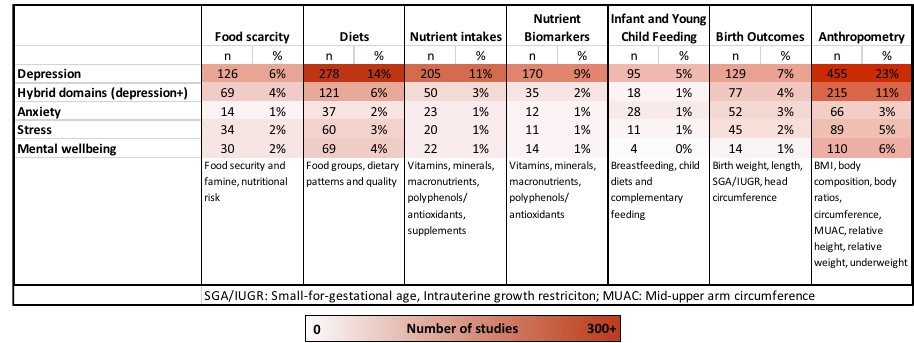
Fig. 2 | Heat map of included studies. Rows are measures of mental health, columns are measures of food security and nutrition.